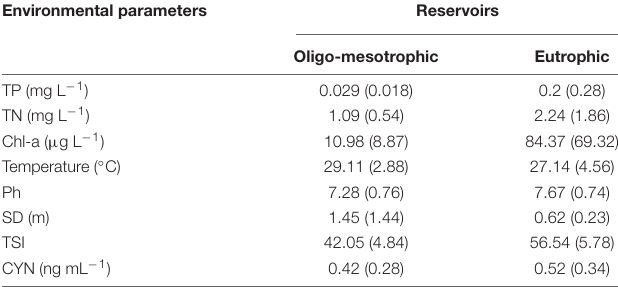
TABLE 2 | Mean ( ± SD) of environmental parameters in oligo-mesotrophic ( n = 78) and eutrophic ( n = 37) (sub)tropical reservoirs in southern